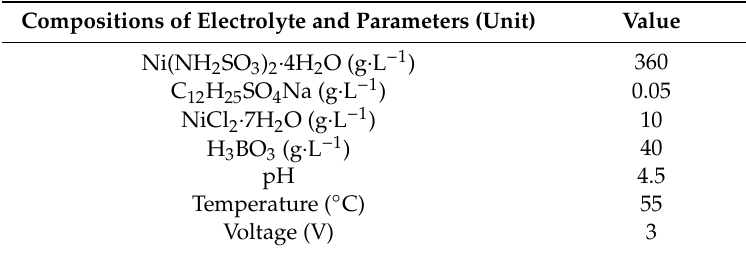
Table 2. Compositions of electrolyte and electrodeposition parameters.